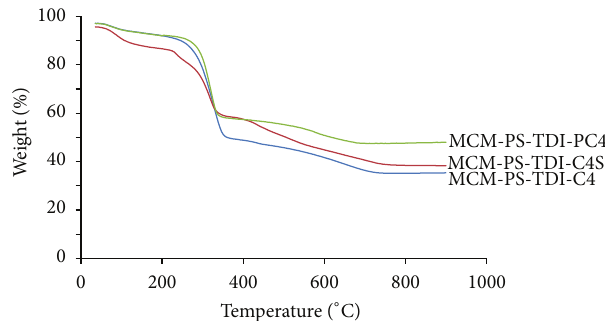
Figure 4: TGA analysis of MCM-PS-TDI-C4, MCM-PS-TDI-C4S, and MCM-PS-TDI-PC4.